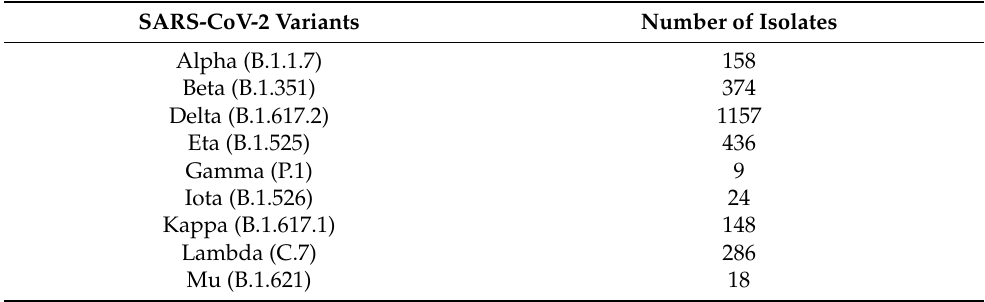
Table 1. The number of ORF1ab from SARS-CoV-2 variants included in the study. The sequences were retrieved from NCBI Virus SARS-CoV-2 Data Hub on 22 September 2021 in FASTA format. All sequences were of complete length between 7093 and 7096 amino acids and contained no ambiguous amino acid characters. The delta sequences were selected only from isolates collected between 31 July and 22 September